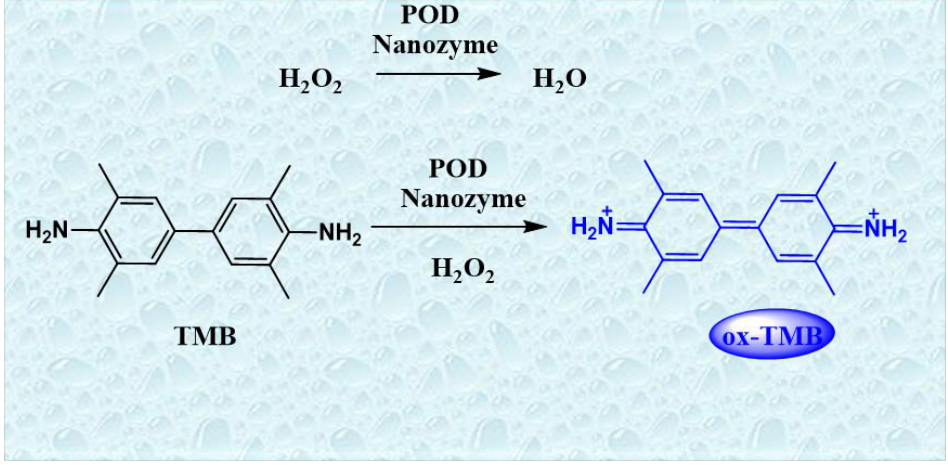
Figure 2. Schematic representation of POD mimetic assay.